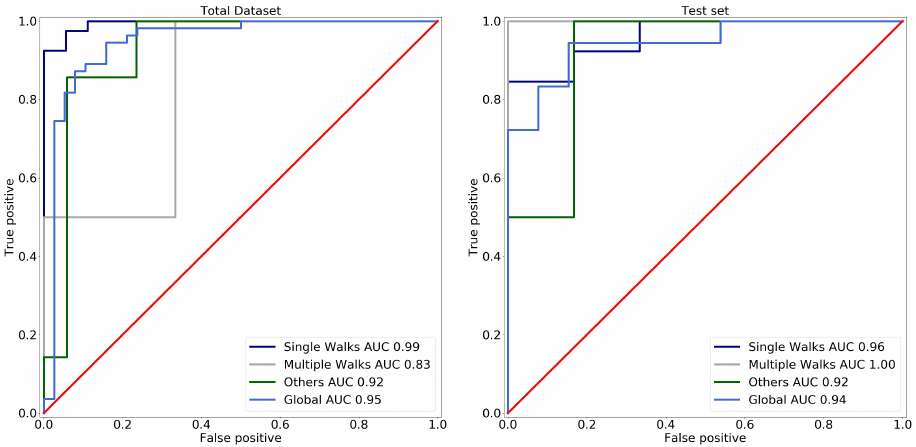
Figure 10. ROC obtained when classifying between medical staff and elderly individuals for different activities (single individual walk, multiple individuals walks, other) using N URSE N ET on ( left ) the entire dataset and ( right ) the test set. Performances are similar in both